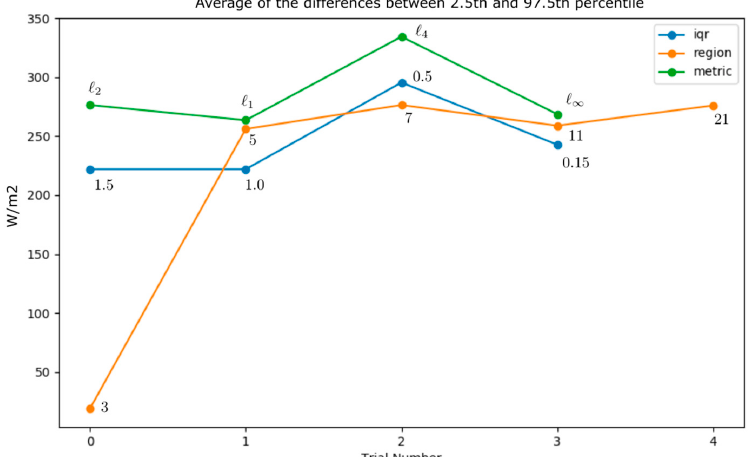
Figure 12. Trend of average of the difference between 97.5th and 2.5th percentiles for preserved scenarios for the winter: (blue) n R = 7 and metric = ℓ (cid:2870) -Norm and varying p : 1.5, 1, 0.5, and 0.15; (green) n R = 7, without outlier removal and varying metric : ℓ (cid:2870) -Norm, ℓ (cid:2869) -Norm, ℓ (cid:2872) -Norm, and ℓ (cid:2998) -Norm; (orange) metric = ℓ (cid:2870) -Norm, without outlier removal and varying n R : 3, 5, 7, 11, adn 21. The text in the graph indicates the values assumed by the varied parameters.